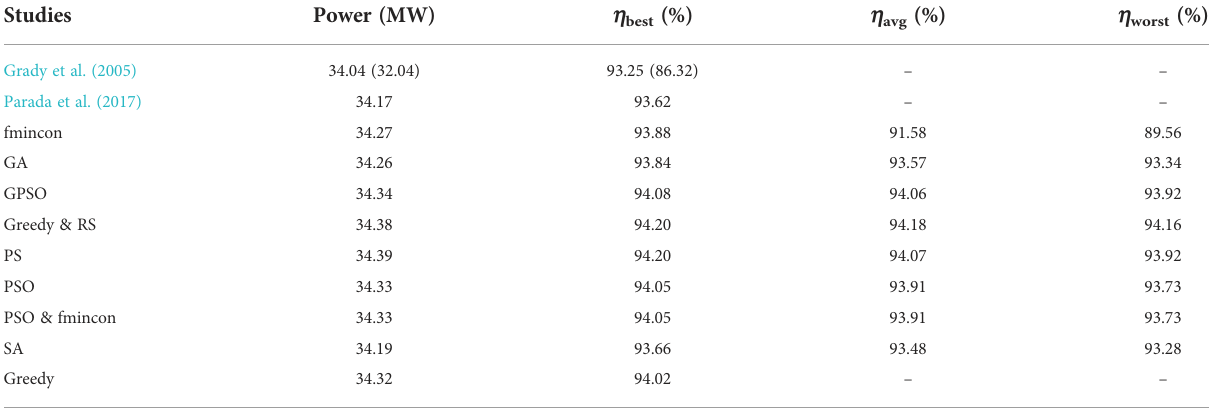
TABLE 4 Comparison of global best solutions of different algorithms. Studies